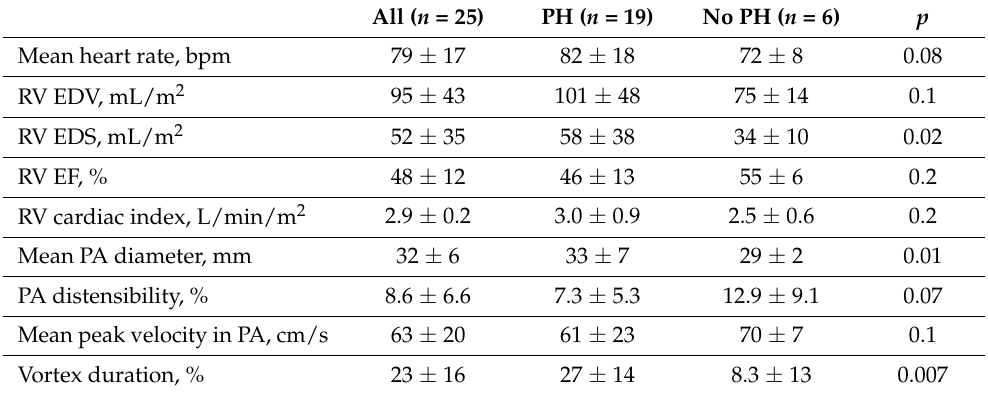
Table 2. Cardiac MRI parameters in the overall population and between patients with and without pulmonary hypertension on RHC (defined as a mean pulmonary pressure > 20 mmHg).